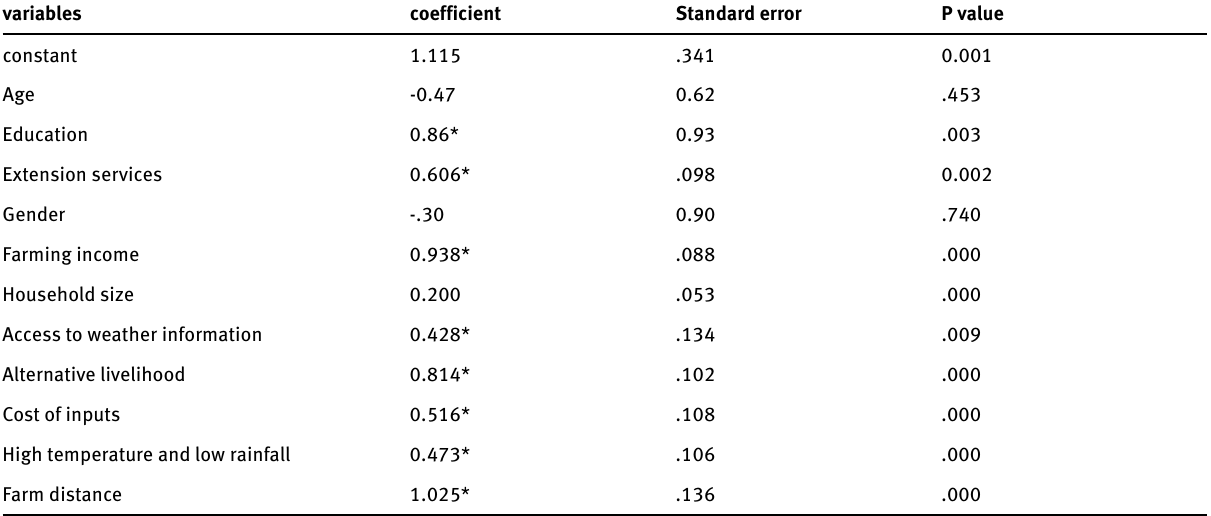
Table 2: Determinants of climate change adaptation barriers. (N=225)